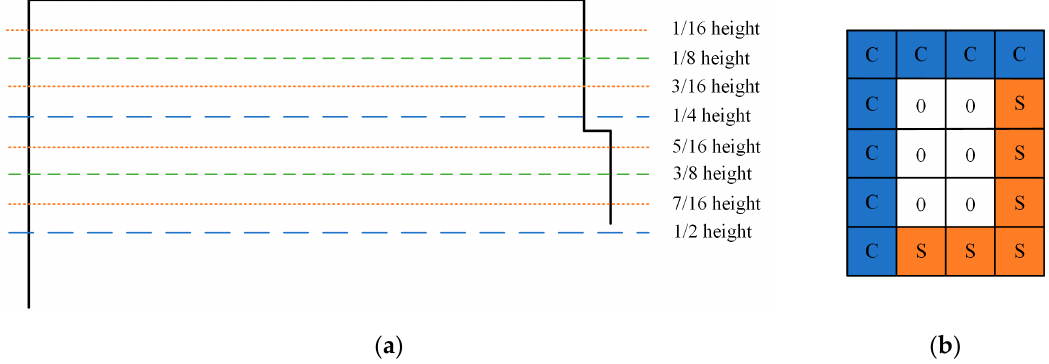
Figure 4. Grid-slices analysis approach: ( a ) several slices of different distances to the ceiling, ( b ) region detection in slices (“C” for ceiling grid, “S” for slice grid, “0” for the empty grid).